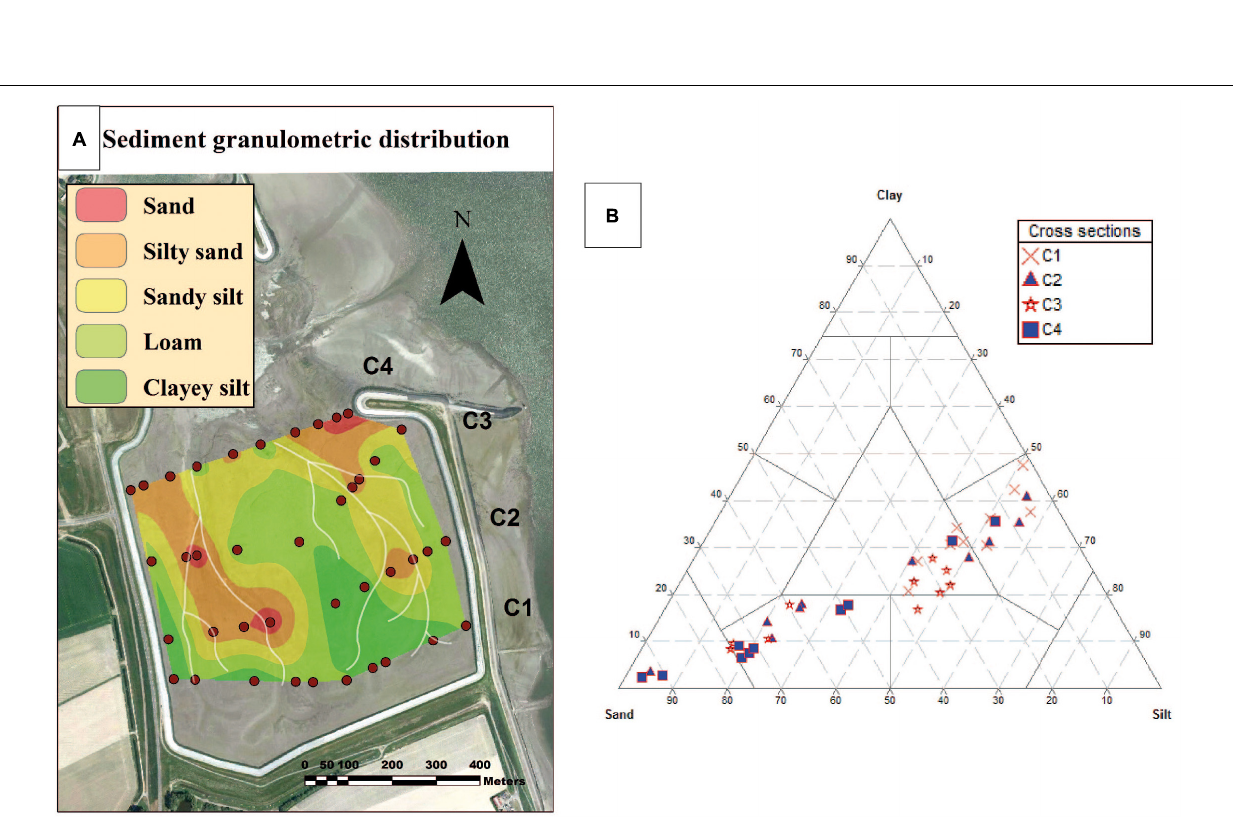
FIGURE 7 | On the left (A) sediment granulometric distribution map derived from the analysis of 40 samples collected in Perkpolder. The map was produced using the natural neighbor interpolation. On the right (B) Shepard’s diagram shows how all samples result from a mixture of end-members of dominant sand and silt